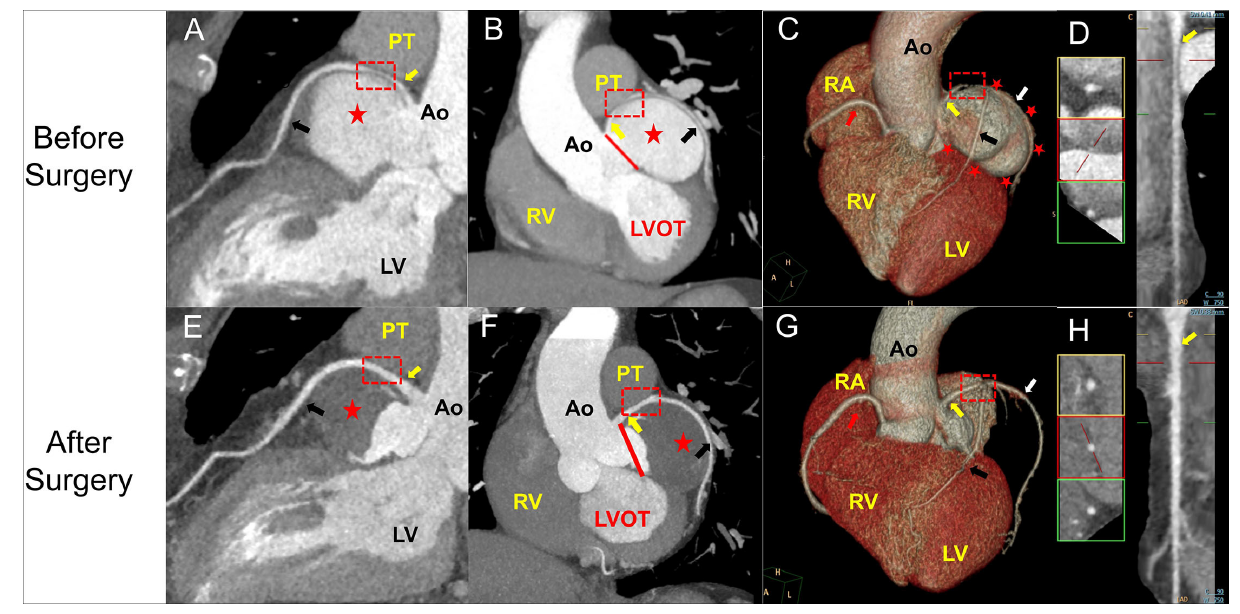
FIGURE 2 | Coronary computed tomography angiogram (CCTA) images of the SoVA obtained before (A–D) and after (E–H) surgical treatment. (A,E) show a continuous curved vessel reconstruction of the left main and left anterior descending coronary arteries based on enhanced spiral CT before (A) and after the surgery (E) . (B,E) show the CT coronal section of the reconstructed heart before (B) and after (F) the surgical exclusion. (C) shows a three-dimensional reconstruction model of the aneurysm before surgery, and (G) shows the same view absent the aneurysm after the surgical exclusion. (D,H) show the long-axis curvilinear reformation of the left main coronary artery (LMCA) before (D) and after the surgery (H) . LMCA is identified with a red rectangle demonstrating extrinsic compression before surgery that has resolved after. The PT and LA were eliminated in (C,F) to show the LMCA. LMCA, left main coronary artery (yellow arrow); LAD, left anterior descending coronary artery (black arrow); PT, pulmonary trunk; LV, left ventricle; Ao, aorta; RV, right ventricle; LVOT, left ventricle outflow tract; LV, left ventricle; red star, SoVA; red line, the neck of the aneurysm; red arrow, right coronary artery; white arrow, left circumflex coronary